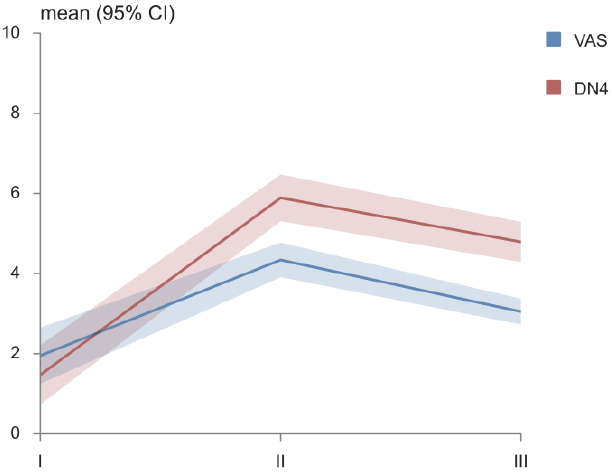
Figure 3. EORTC QLQ – C30 — European Organization for Research and Treatment of Cancer – Qual-